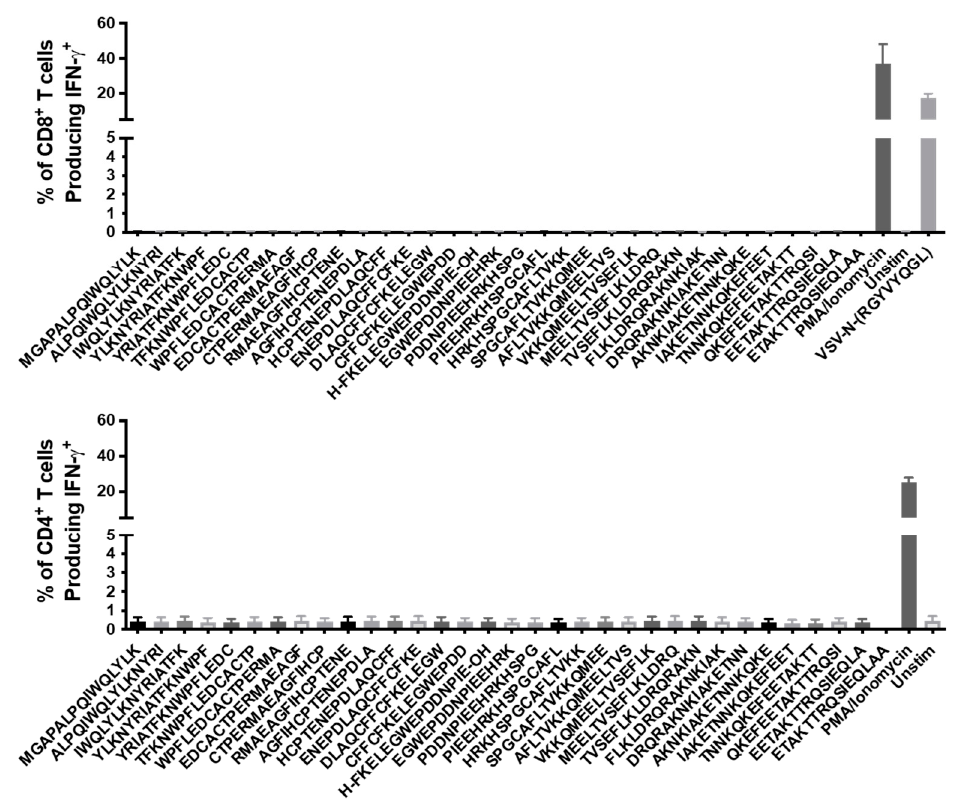
Figure 5. Blocking CTLA4 was unable to rescue the lack of immunogenicity of murine survivin. C57BL/6 mice were given 200 µ g of a CTLA4-blocking antibody intraperitoneally 24 h prior to vaccination, as well as 100 µ g one hour before vaccination. The mice were then vaccinated with Ad48-T34A-mSurvivin at 1 × 10 8 ifu and boosted 14 days later with MG1-T34A-mSurvivin at 1 × 10 9 pfu. Intracellular cytokine staining following peptide re-stimulation at the expected peak of the secondary T cell response failed to reveal detectable survivin-specific CD8 + ( top ) or CD4 + ( bottom ) T cell